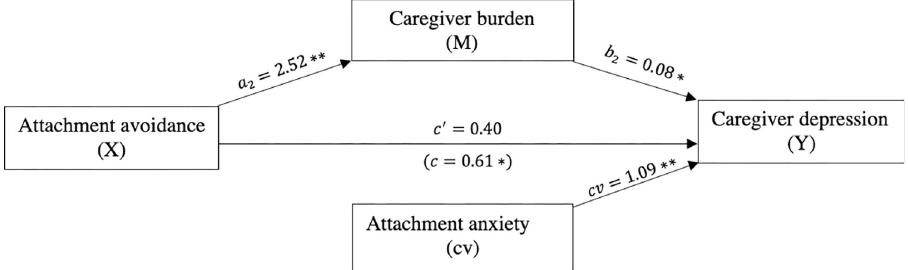
Fig 5. The mediating effect of caregiver burden in the relationship between attachment avoidance and caregiver depression. � p < 0.05, �� p < 0.001, cv = covariate.